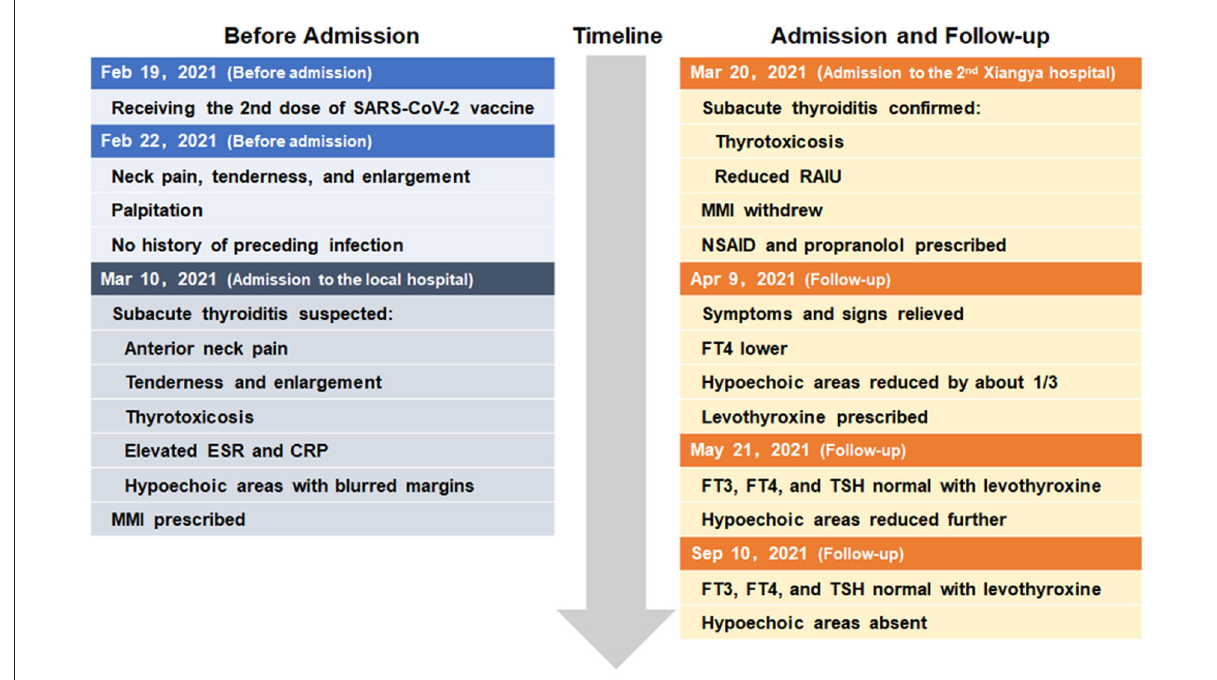
FIGURE3 The whole timeline of clinical